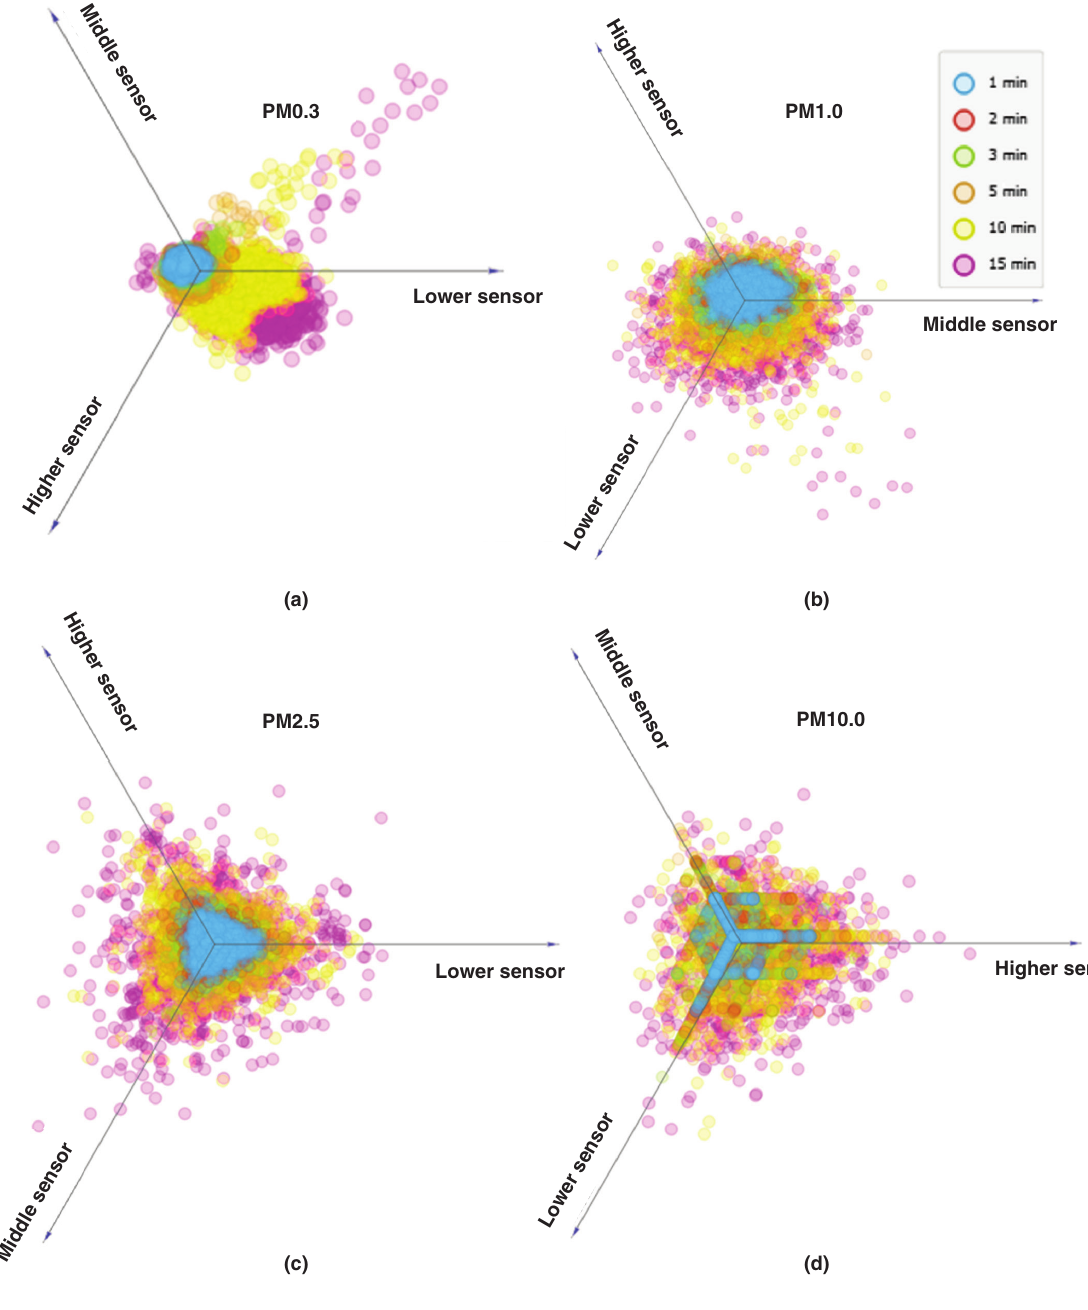
Figure 8 Linear projection of (a) PM0.3 (b) PM0.5 (c) PM2.5 and (d) PM10.0 at different heights. (Source: Authors,